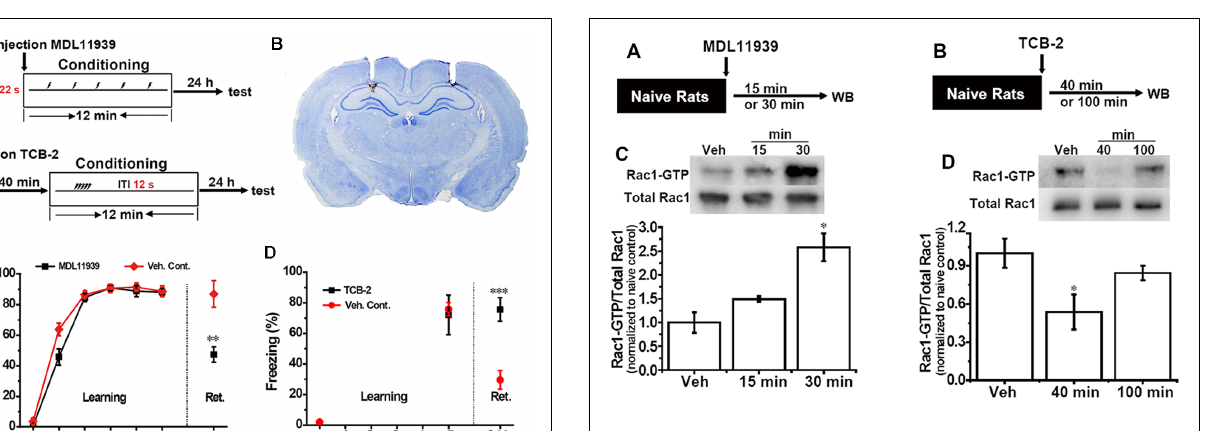
FIGURE 3 | Inhibition of hippocampal 5-HT2A receptors activates Rac1 activity, activation of hippocampal 5-HT2A receptors inhibits Rac1 activity. (A,B) Diagrams of experimental procedures. (C) Hippocampal administration of 5-HT2A receptor antagonist MDL11939 increased Rac1 activity 30 min after administration. (D) Hippocampal administration of 5-HT2A receptor agonist TCB-2 inhibited Rac1 activity 40 min after administration. n = 4 for each group. All results were presented as mean ± SEM, ∗ p <